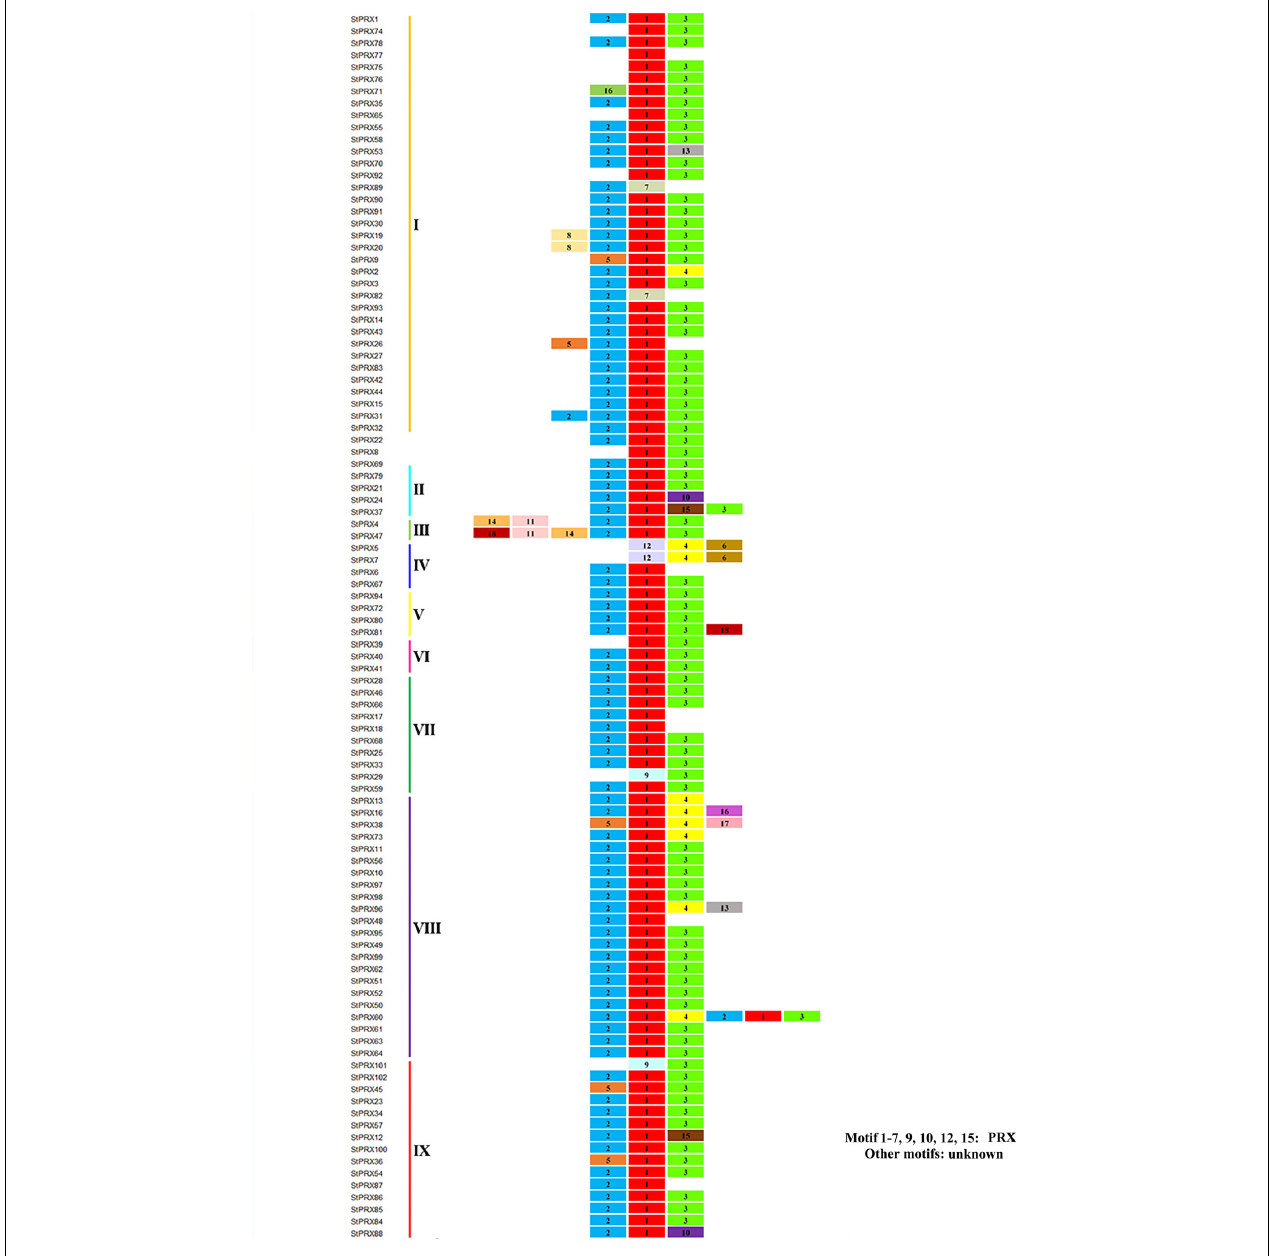
FIGURE 3 | Conserved motifs of PRX proteins in potato. The protein list on the left is the same as that in Figure 1 . The genes of different subfamilies are highlighted with different colors. Different motifs are exhibited with different colored boxes and numbers (1–18). The detailed sequences of motifs are listed in Supplementary Table S2 .